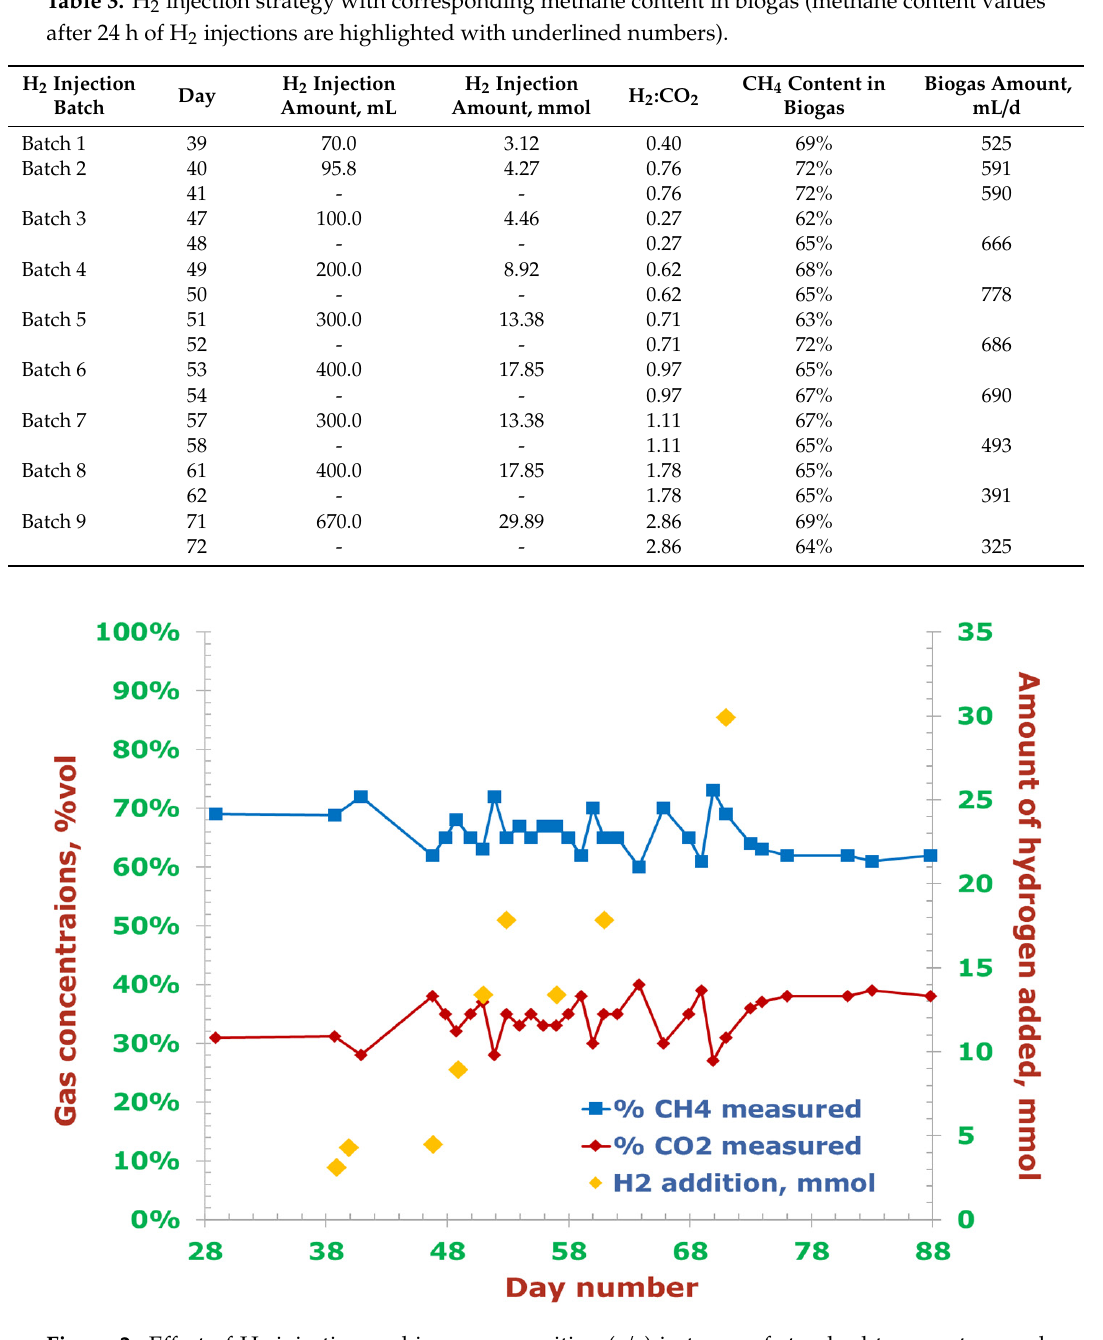
Table 3. H 2 injection strategy with corresponding methane content in biogas (methane content values after 24 h of H 2 injections are highlighted with underlined numbers).